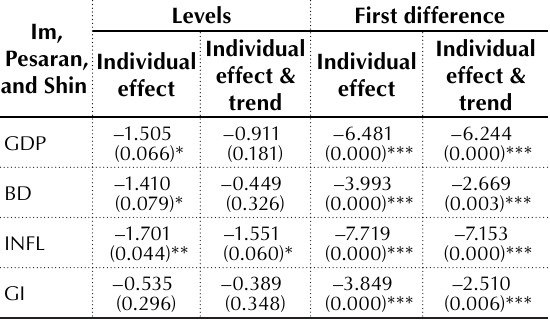
Table 2. Panel unit root results: Im, Pesaran, and Shin test